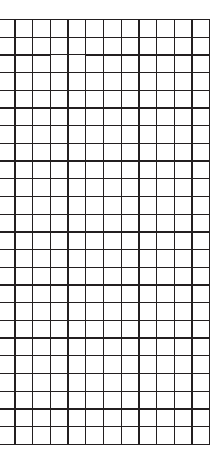
Figure 6: Grids used in Terzaghi’s